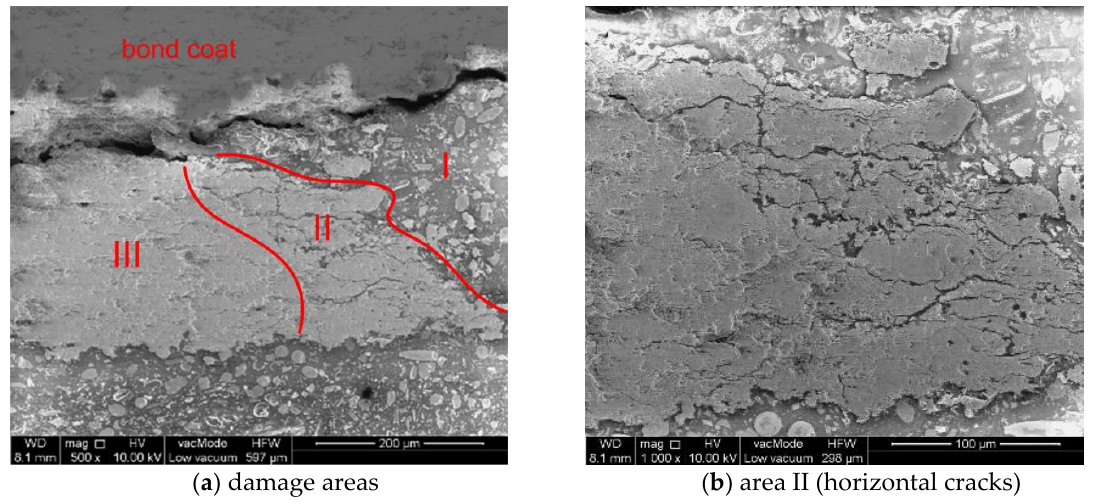
Figure 3. Damage areas of the top-coat.